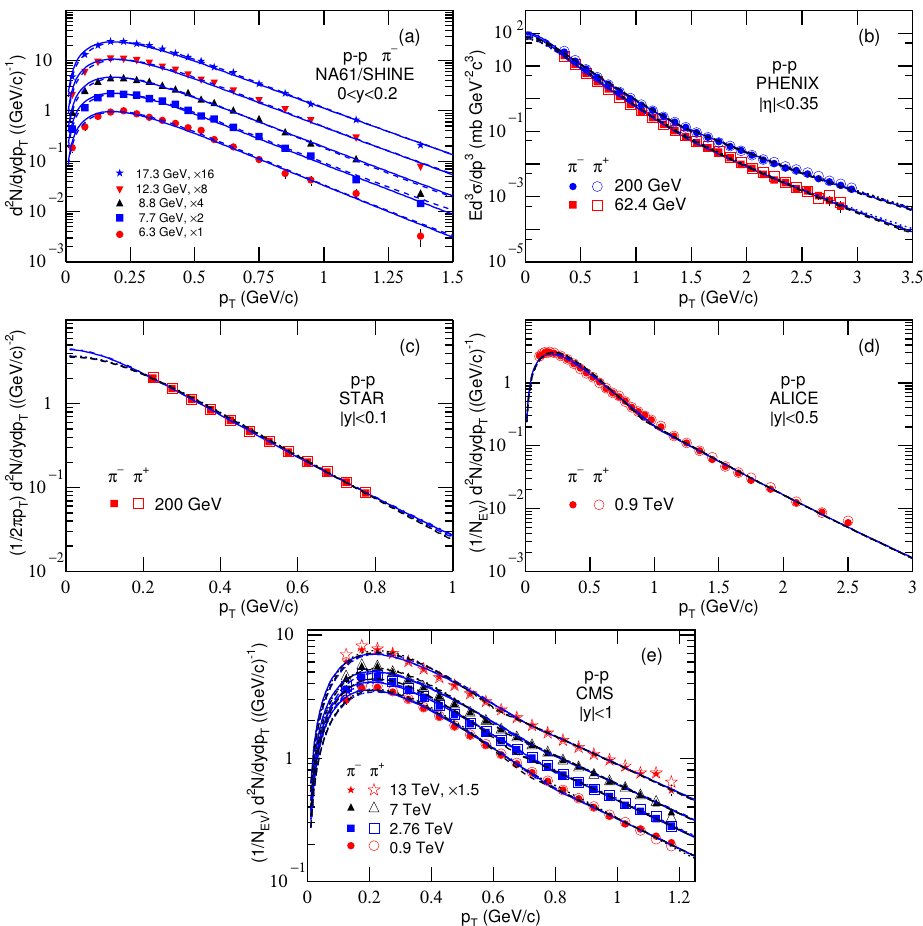
Figure 4. Same as Figure 1, but showing the results fitted by Equation (8) through Equations (1) and (3) with one set of parameter values and by Equation (8) through Equations (2) and (3) with two sets of parameter values, where in panel ( a ) only the spectra of π − are available, and panel ( c ) is for NSD events and panels ( b , d , e ) are for INEL events. The blue solid (dotted) curves are the results for π − ( π + ) spectra fitted by Equation (8) through Equations (1) and (3), and the blue and black dashed (dot-dashed) curves are the results for π − ( π + ) spectra fitted by Equation (8) through Equations (2) and